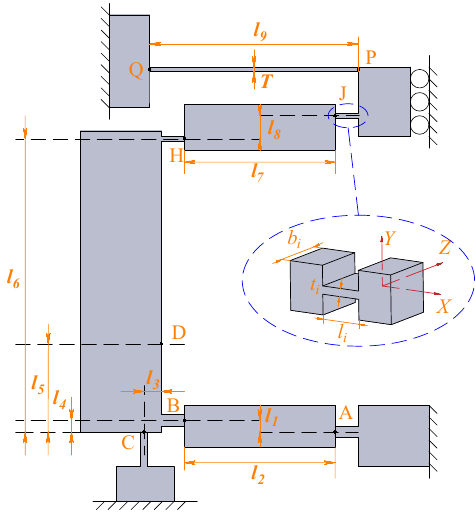
Figure 5. Structures of the half HBLB mechanism and flexure